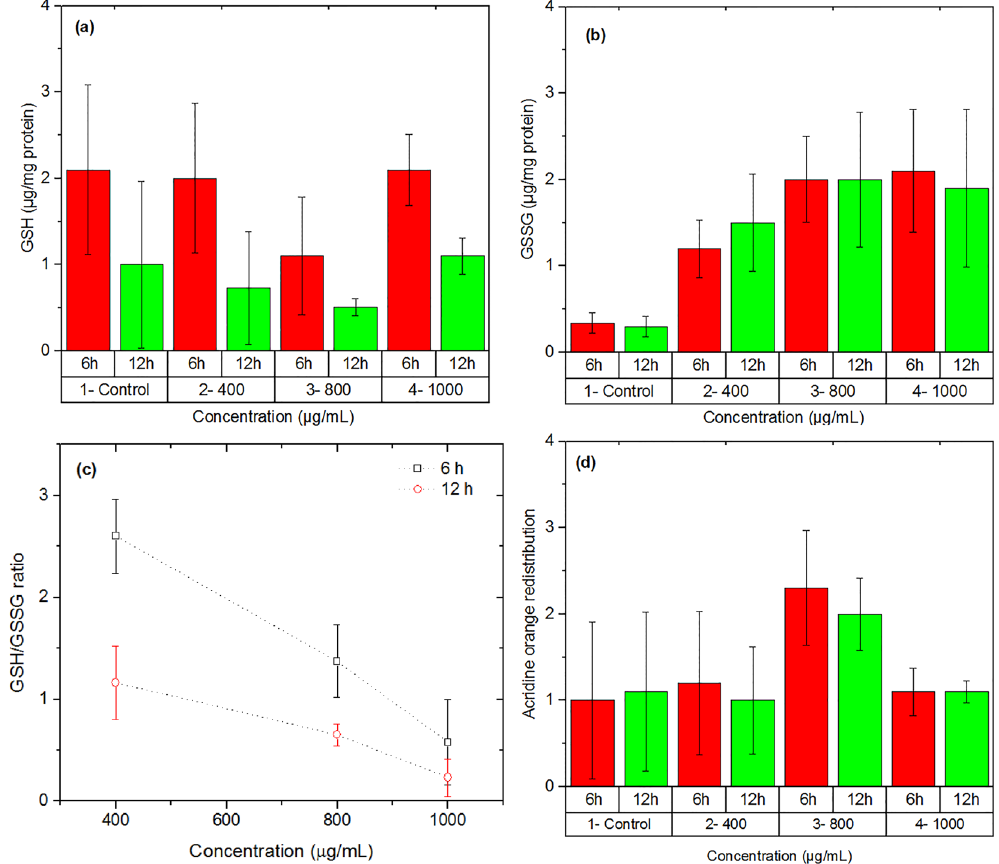
Figure 4. Effect of hybrid nanoparticles on glutathione in both ( a ) reduced (GSH) and ( b ) oxidized (GSSG) states. ( c ) The ratio of GSH/GSSG indicates the role of nanoparticles on the oxidative stress. The dot lines only show the trend of variations to help eyes. ( d ) Changes in acridin orange (a lysosomotropic agent) indicate possible lysosomal damage by the